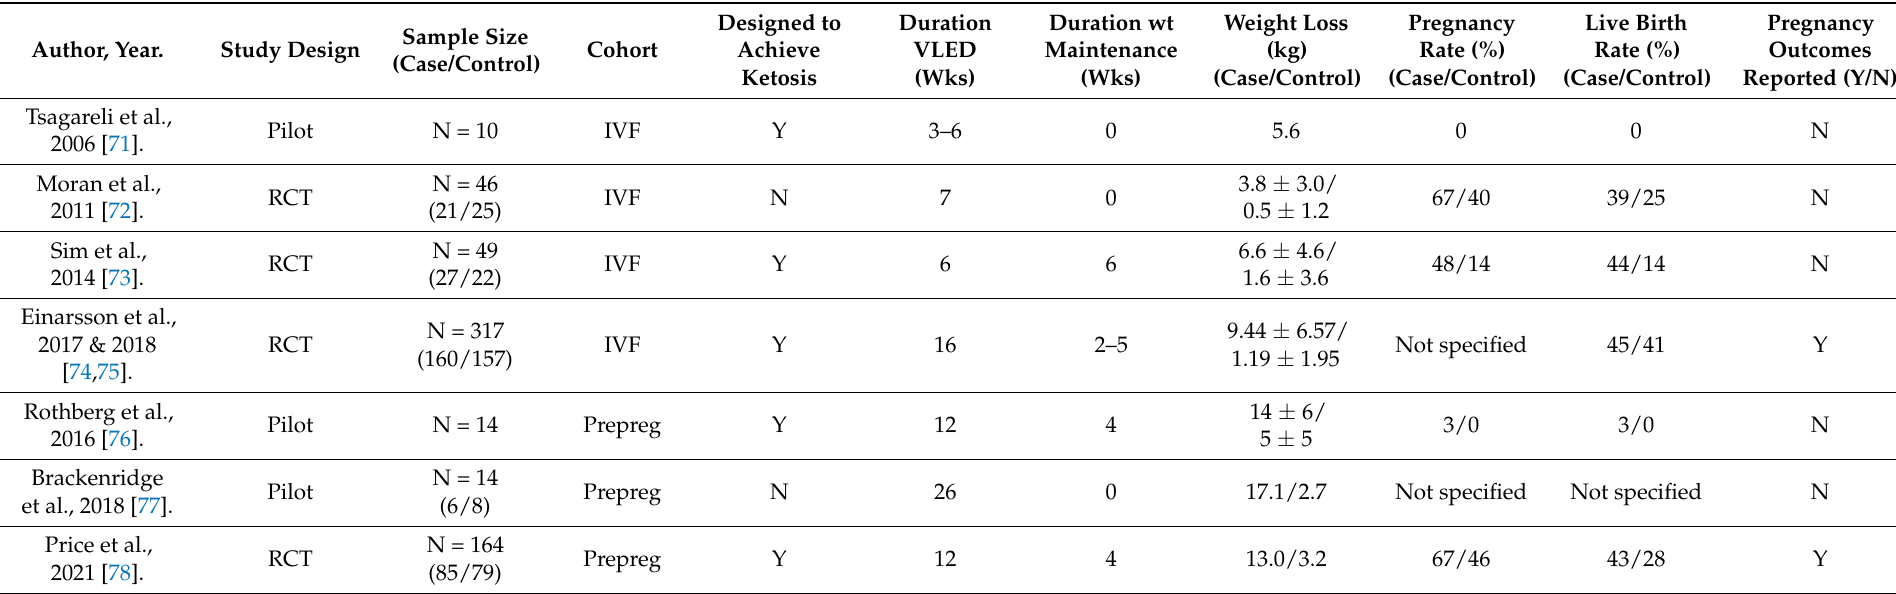
Table 1. Summary of studies that used a VLED program as a tool to achieve weight loss in women with obesity prior to